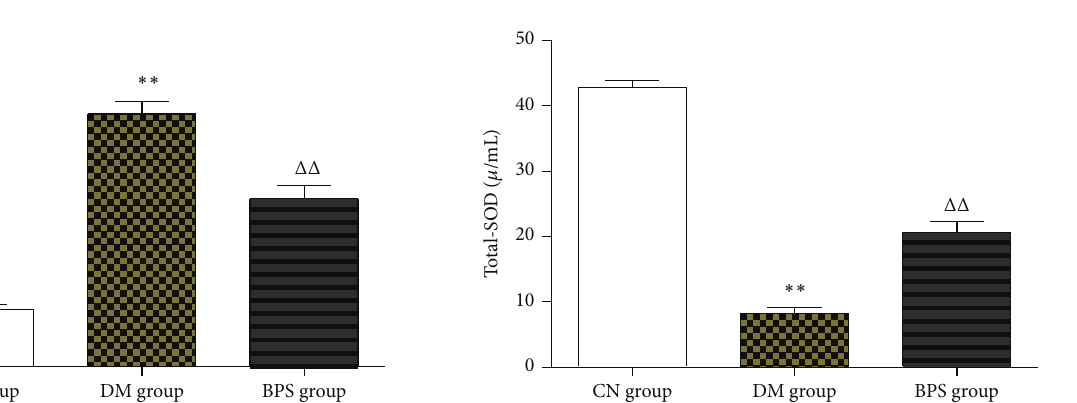
Figure 3: SOD in each group. Compared with CN group, the level of totalSODsignificantlydecreasedbothinBPSandinDMgroup( 𝑃 < 0.01 ). Compared with DM group, the level of total SOD significantly increased in BPS group ( 𝑃 < 0.05